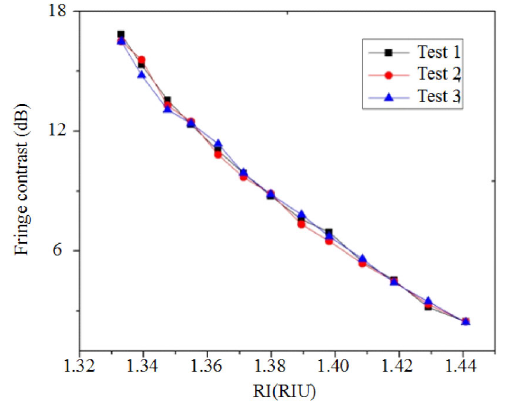
Fig. 6 Relationship between the maximum fringe contrast ( V max ) and external RI for three